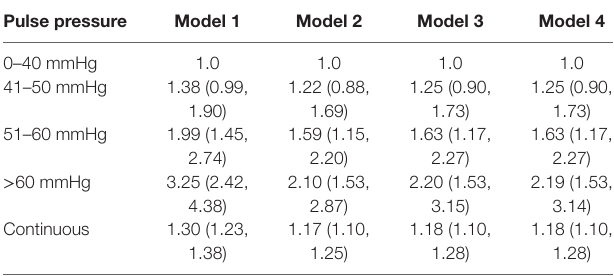
TaBle 4 | Association between pulse pressure and peripheral arterial disease incidence, hazard ratio (95% confidence interval).